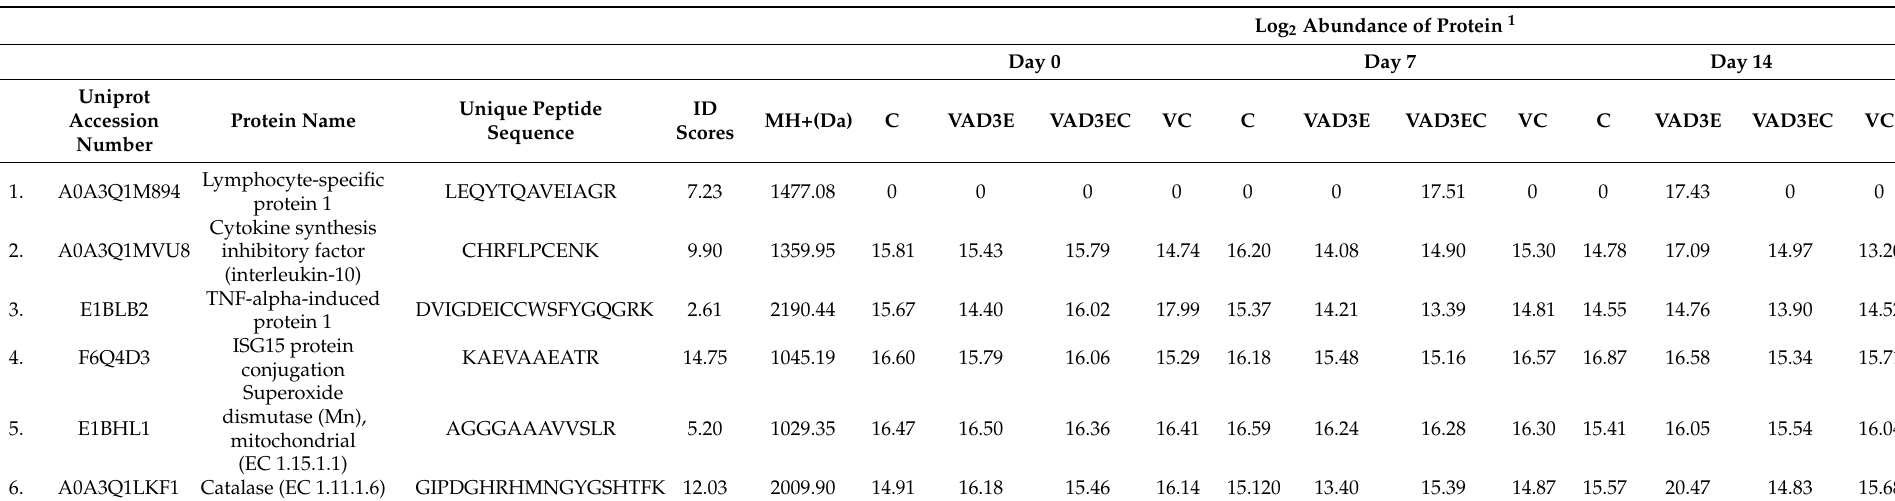
Table 6. The list of differentially abundant proteins in all treatments during different